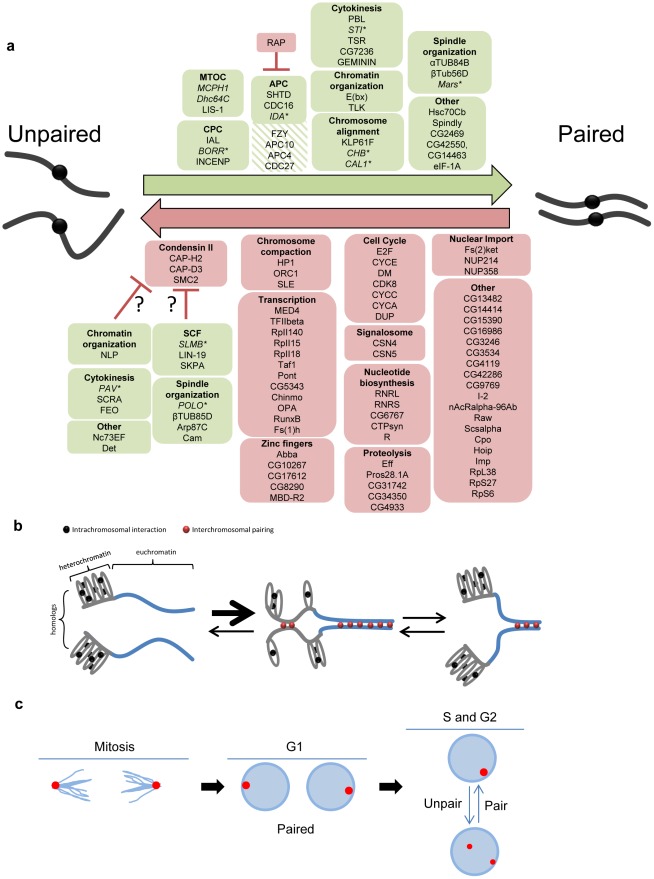
Pairing models involving both candidate pairing promoting and anti-pairing factors.a, Summary of candidate pairing factors identified in the screen. Green boxes denote candidate pairing promoters (hatched green were those identified only in the primary screen) and red boxes denote candidate anti-pairers. A representative sampling of pairing promoters were tested (italicized) and found (asterisk) to be important for euchromatic pairing. Proteins are grouped based on either a known function or localization pattern. Candidate pairing promoters found to elicit RNAi phenotypes dependent on Cap-H2 are presented as potential condensin II regulators (question marks). Note one dsRNA targets both CG42550 and CG14463 (separated by comma). b, Model for how compaction and intrachromosomal interactions compete with homolog pairing. Although all chromosomal regions may transiently unpair prior to or during S-phase, homolog pairing (red circles) of heterochromatic centromeric regions (grey lines) may be in competition with intrachromosomal interactions (black circles), causing pairing to occur less often, more slowly, or with less stability than homolog pairing of less compacted euchromatic regions (blue lines), where the paucity of repeated sequences reduces the likelihood of intrachromosomal interactions. This figure is not meant to imply a causal or dependent relationship between heterochromatic and euchromatic pairing, although such a relationship may exist. c, Model for pairing through the cell cycle. Proper spindle formation and chromosome segregation during anaphase/telophase of mitosis may bundle centromeric heterochromatic regions to spindle poles and directly facilitate or accelerate homolog recognition. Such interactions would then be maintained through G1. During S-phase, however, the pairing of regions is perhaps more dynamic, becoming antagonized and then re-paired subsequently. In this case, not all pairing interactions would be reestablished until the following mitosis. Euchromatic pairing is not depicted.